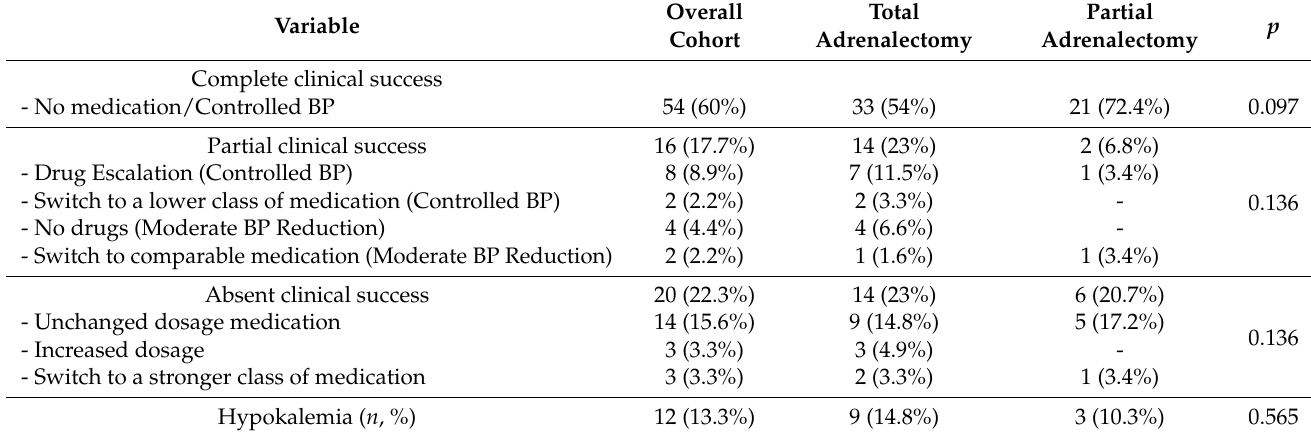
Table 3. Functional Outcomes according to PASO